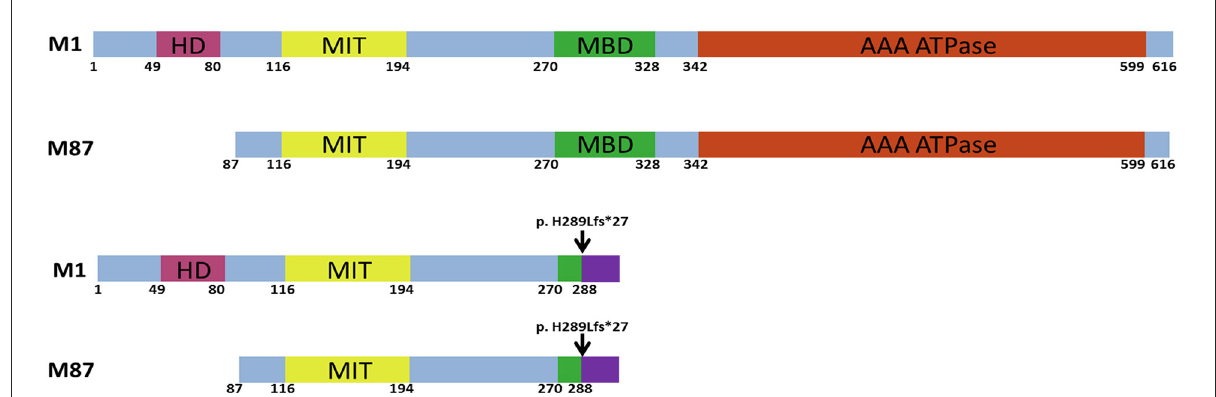
FIGURE1 Schematic structure of the human wild-type and mutant spastin proteins. M1 and M87 spastin isoforms are presented. HD, hydrophobic domain; MIT, microtubule interacting and transport domain; MBD, microtubule-binding domain; AAA ATPase, ATPase associated with diverse cellular activities domain. The black arrow indicates the location of the c.862_863dupAC frameshift